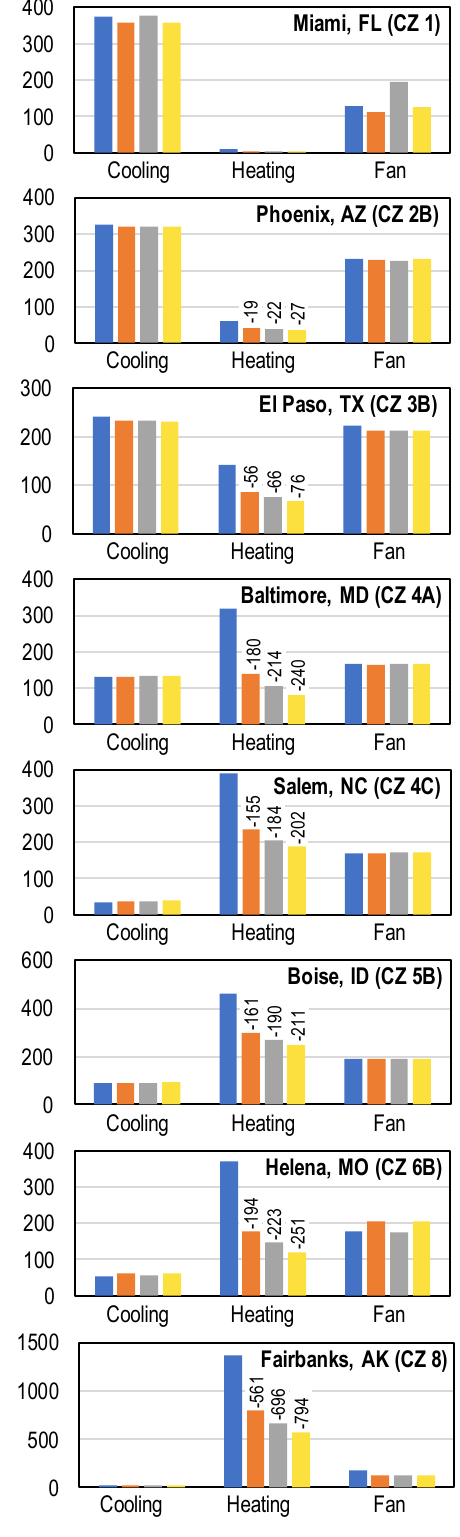
Figure 2. Annual HVAC energy usage in the stand-alone retail prototype buildings for the four assessed air leakage rates in 15 cities representative of DOE’s climate zones. Numbers above bars indicate the difference in energy use with respect to the baseline.